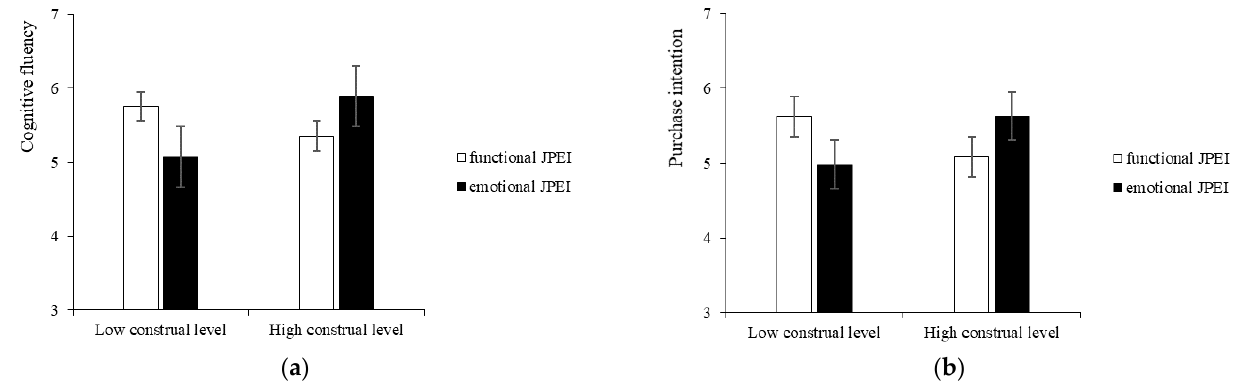
Figure 5. The interactive effect of the information type of JPEI and consumer’s construal level (Study 3). Note: ( a ) shows the interaction effect with cognitive fluency as the dependent variable; ( b ) shows the interaction effect with purchase intention as the dependent variable.